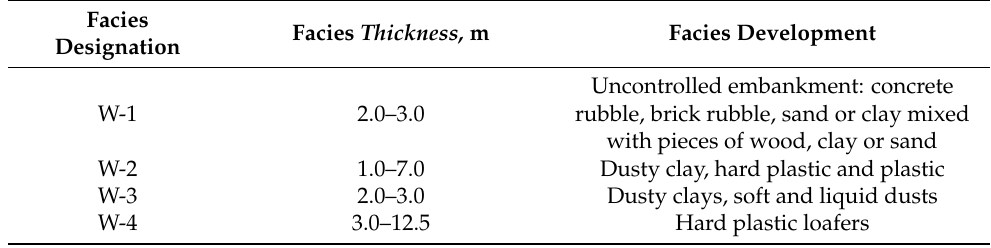
Table 1. Separate generalized facies in the immediate vicinity of the Kosciuszko shaft